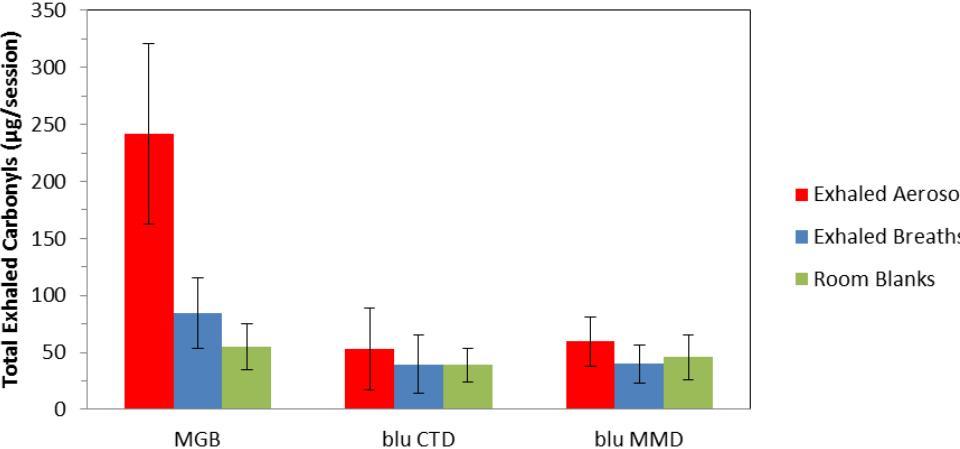
Figure 5. Total carbonyls in exhaled aerosol, breaths and room blanks for Marlboro Gold Box (MGB), blu Classic Tobacco Disposable (blu CTD) and blu Magnificent Menthol Disposable (blu MMD).